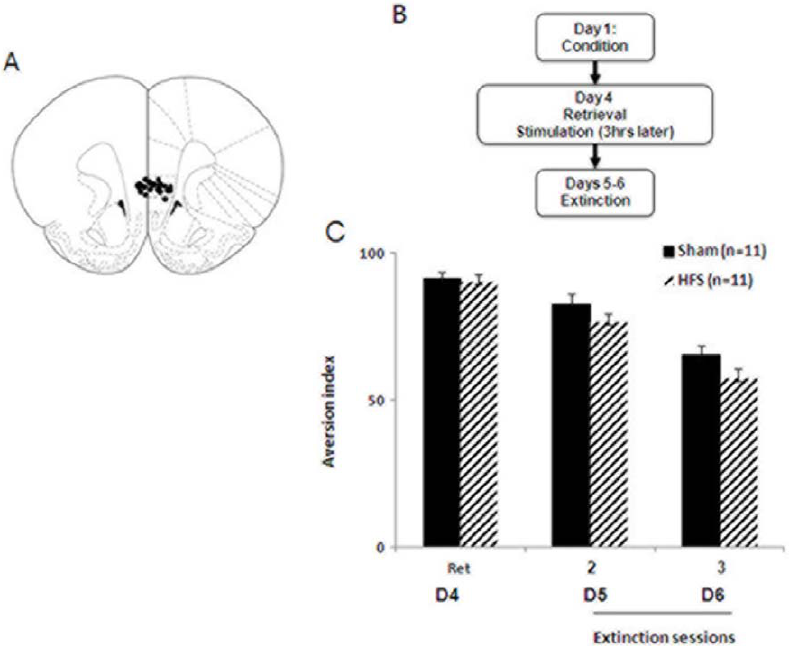
Figure 5. IL-HFS applied immediately after CTA retrieval/short extinction does not affect the aversion index during extinction. ( A ) Schematic diagram showing electrode placement in IL for the CTA experiment. ( B ) Timeline of behavioral testing and stimulation. ( C ) Aversion index (mL water drunk/total fluid drunk 6 100) during conditioning, retrieval, and extinction in rats receiving either sham or HFS 3 hrs after retrieval. HFS rats were not different from Shams. Data are Means 6